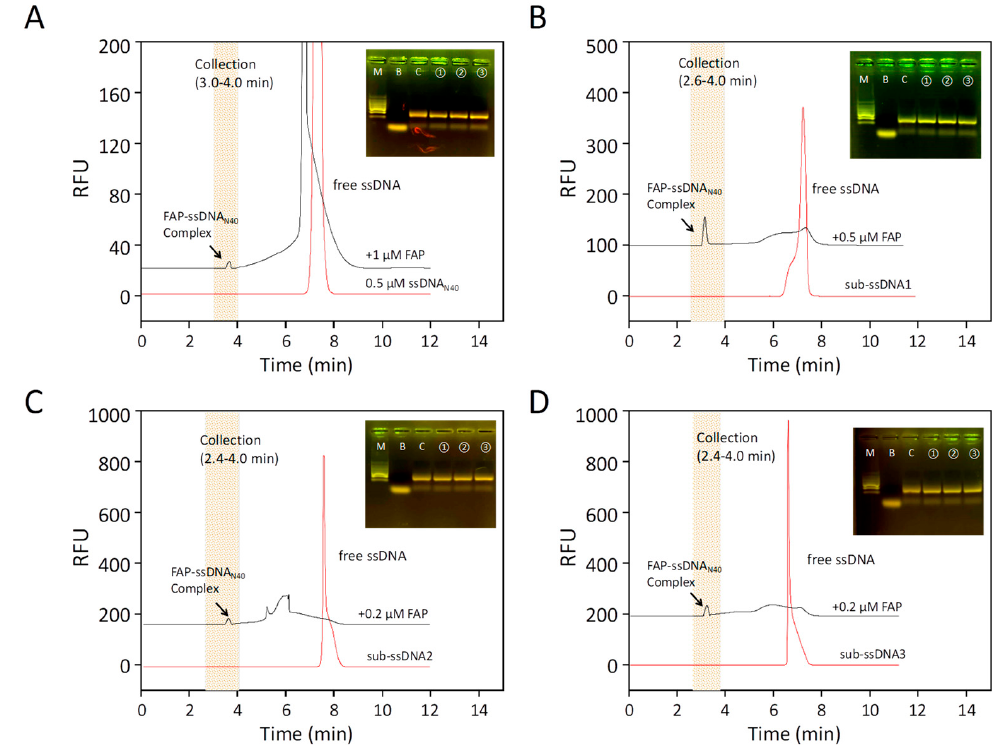
Figure 1. CE-SELEX for FAP aptamers. ( A ) The capillary electrophoresis chromatogram of the first round of screening. The red chromatogram shows the 0.5 μ mol/L nucleic acid libraries (ssDNA N40 ) alone, and the black chromatogram shows the incubated mixture of 0.5 μ mol/L ssDNA N40 and 1 μ mol FAP. Arrows indicate the complex formed by the combination of FAP and ssDNA N40 . The shaded part is the complex collection segment of 3.0–4.0 min. ( B ) The second round of screening. The red chromatographic line is the secondary library (sub-ssDNA1), amplified and purified after the first round of screening; the black chromatographic line is the mixture of sub-ssDNA1 incubated with 0.5 μ mol/L FAP; the arrow indicates the complex formed by the combination of FAP and sub-ssDNA1. The collection interval was 2.6–4.0 min. ( C , D ) show the third and fourth rounds of screening. The red chromatographic lines are sub-ssDNA2 and sub-ssDNA3, and the black chromatographic lines are 0.2 μ mol/L FAP incubated with sub-ssDNA2 or sub-ssDNA3. The collection interval was 2.6–4.0 min for both. Lanes of the gel electrophoresis pattern: M is marker; B is blank control; C is PCR control with the nucleic acid library as a template; and ① , ② , and ③ are parallel samples of PCR products.